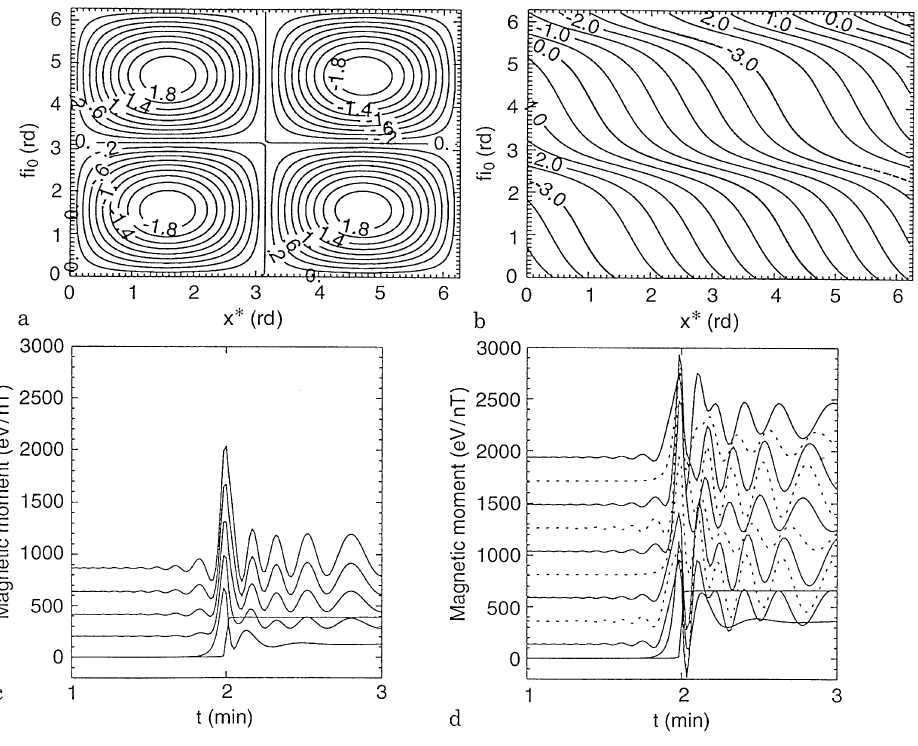
Fig. 10a (cid:177) d. Ion magnetic- moment dependence on time. The coefficients a s (cid:48) and b s (cid:51) of Eq. 11 as functions of x* " g ( t* ) and of (cid:117) - the initial phase of the ion. The magnetic moment as function of time for two different values of the constant A: c 390 rdkms (cid:126)(cid:49) , d 660 rdkms (cid:126)(cid:49) . In c , v (cid:48) " 0, 100, 200, 300, 400 kms (cid:126)(cid:49) , (cid:117) " 1.25 (cid:110) ; d v (cid:48) " 300 kms (cid:126)(cid:49) , (cid:117) " n 0.017 (cid:110) , n " 0, 1, . . . , 9. In each panel the curves are shifted up the multiple of 200 units with respect to the v (cid:48) " 0 and n " 0 curves, for